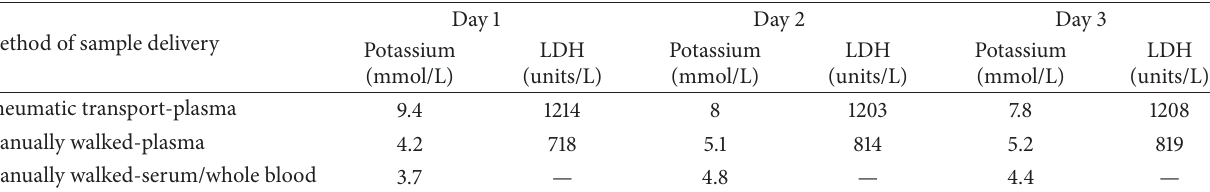
Table 1: Reverse pseudohyperkalemia due to mechanical stress of specimen delivery. Potassium levels at different time points are shown, with respective LDH levels, which differ secondary to delivery mode of blood specimen for